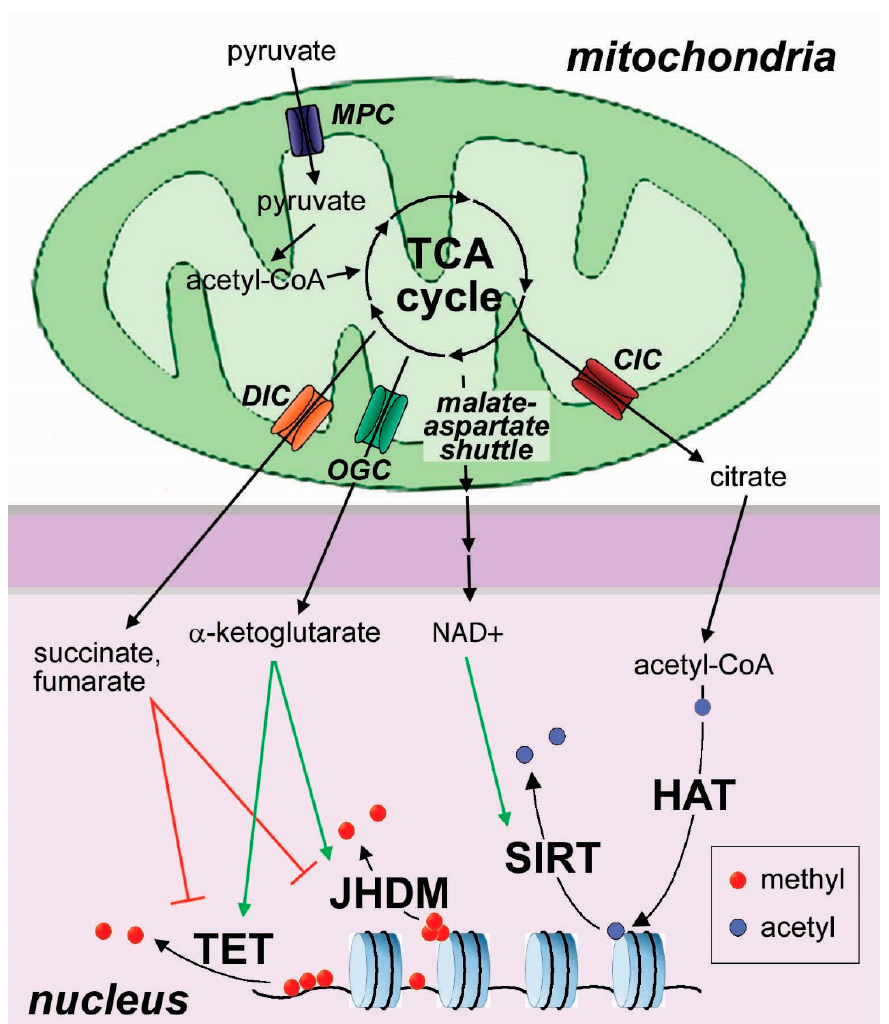
Figure 2. Mitochondrial signaling to the nucleus. The mitochondria act as a metabolic signaling hub, sensing the bioenergetic and oxidative status of the cell and sending signals to the nucleus to regulate gene expression. The mitochondrial pyruvate carrier (MPC), by providing pyruvate to replenish the TCA cycle, is essential for stem cell differentiation. Metabolites exported by the mitochondria through the mitochondrial transport system regulate nuclear enzymatic activities, resulting in epigenetic changes. α KG, exported by the α KG carrier (OGC), activates Jumonji domain ‐ containing histone demethylases (JHDM) and DNA hydroxylases ten ‐ eleven translocation (TET). Succinate and fumarate, exported by the dicarboxylate transporter (DIC), compete with α KG for binding to these